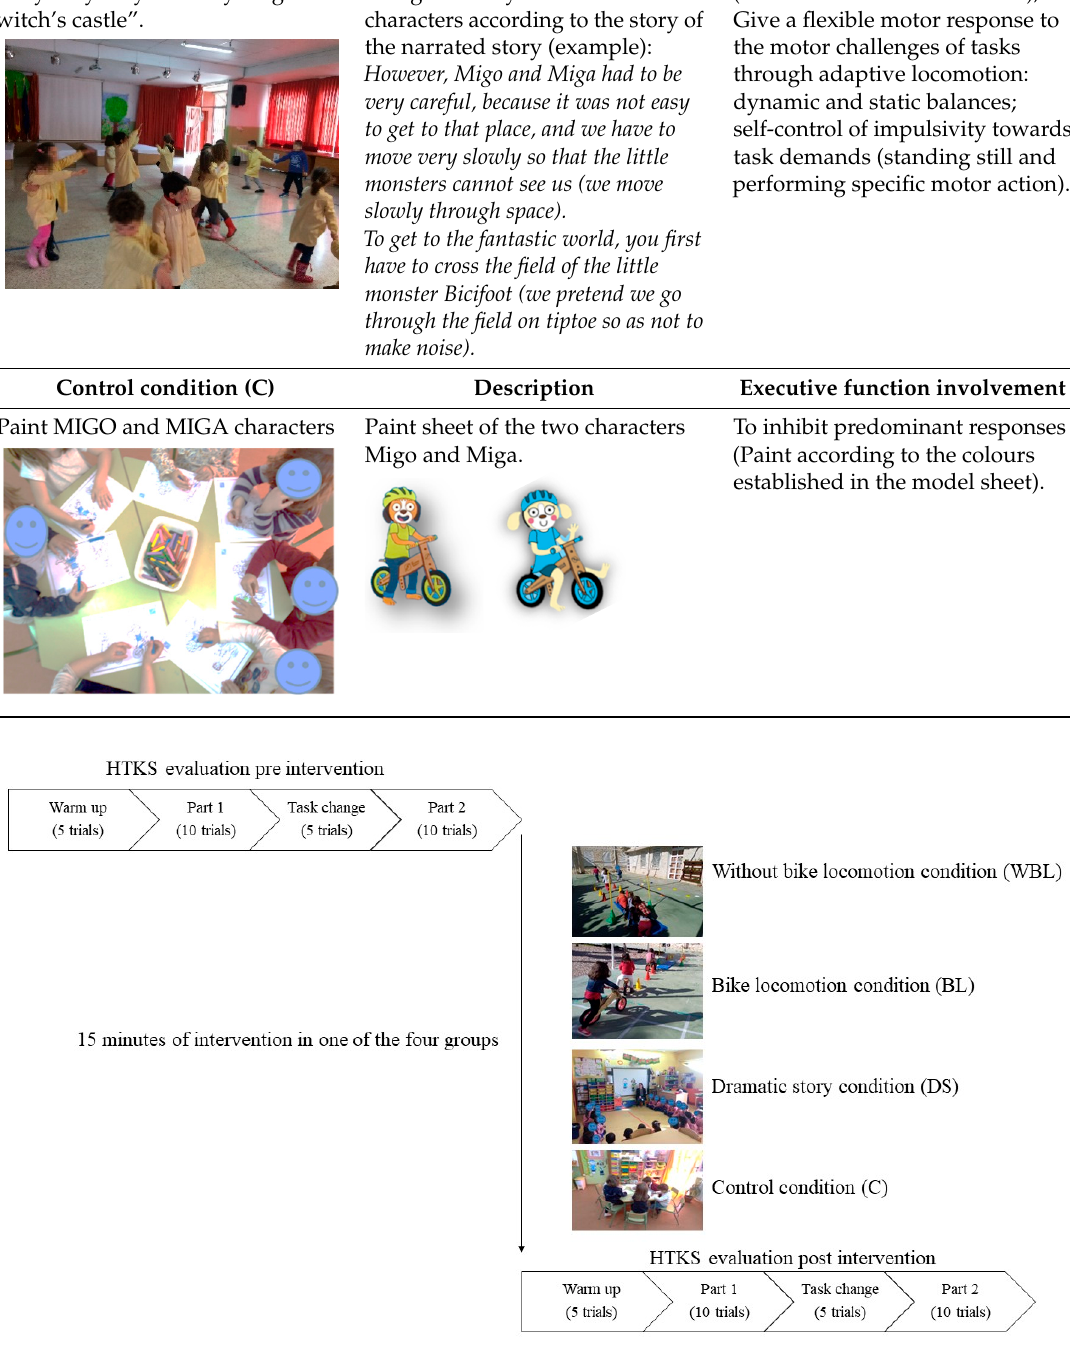
Figure 1. Procedure of the study. Table 1. Description of experimental conditions.